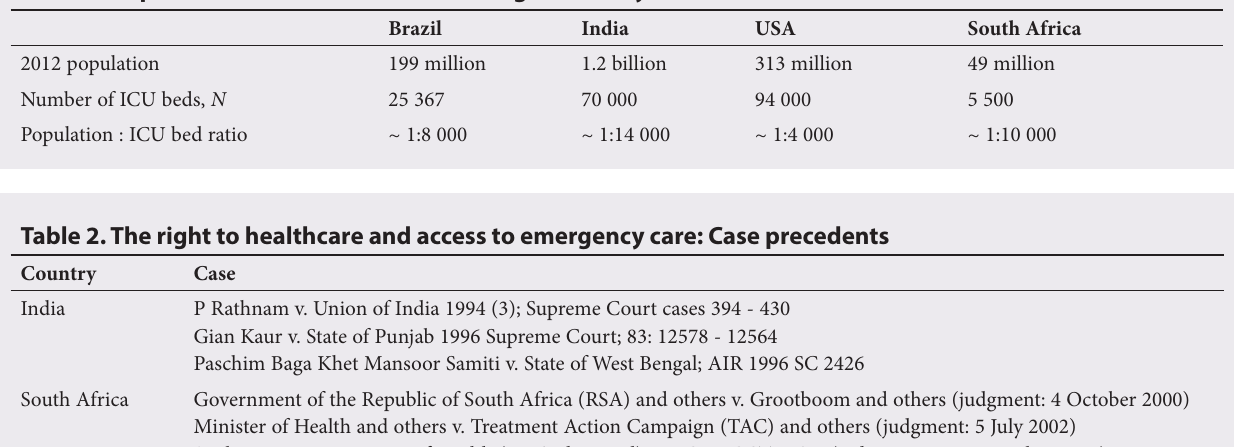
Table 1. Population to ICU bed ratio according to